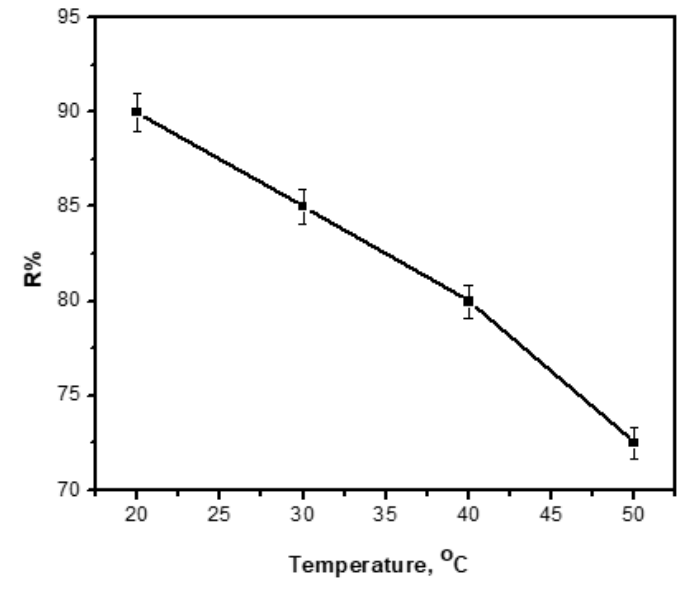
Figure 9. E ff ect of temperature on the removal e ffi ciency of Ni(II) ions by the Figure 9. Effect of temperature on the removal efficiency of Ni(II) ions by the DSP.